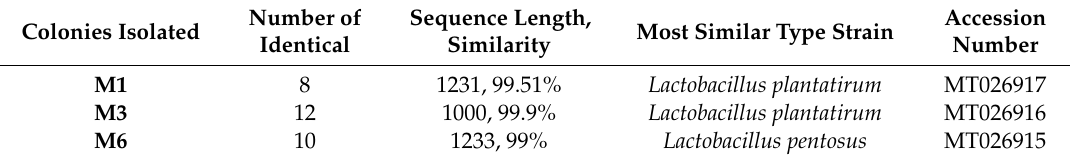
Table 1. The phylotypes of colonies isolated from1st month (M1), 3rd month (M3), and 6th month (M6) breast milk.